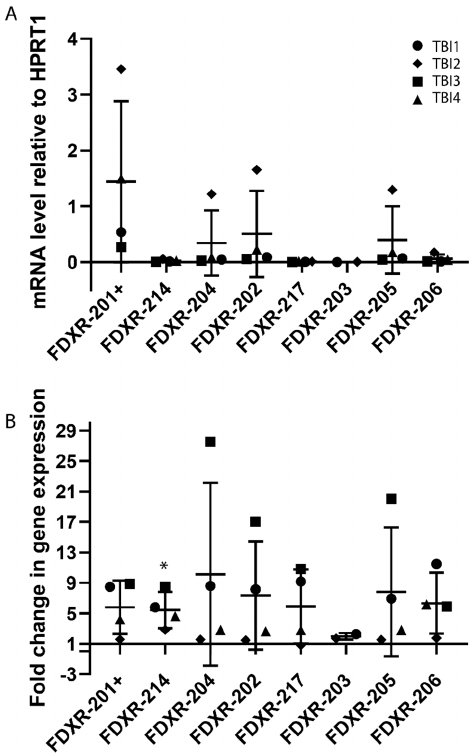
Figure 4. Gene expression profile of FDXR variants in blood samples from total body irradiated patients. The variants basal level of expression was compared between the total body irradiated (TBI) patients ( A ). Total body irradiated patient’s samples ( n = 4) were collected 24 h after the first fraction and 12 h after the second fraction with total received doses of 3.2 (TBI1), 3 (TBI2), 4 (TBI3), and 4 Gy (TBI4) respectively. The fold change is represented in the graph and values over 1 indicate an increase with respect to control values ( B ). Individual data points are shown for all patients, together with the mean ± SD (each patient is represented with a di ff erent symbol). One-way ANOVA followed by Tukey’s test was performed for statistical analysis. No significant di ff erences were found between variants. Significant di ff erences (paired t -test, p ≤ 0.05) with the control were indicated with an asterisk (*) in panel